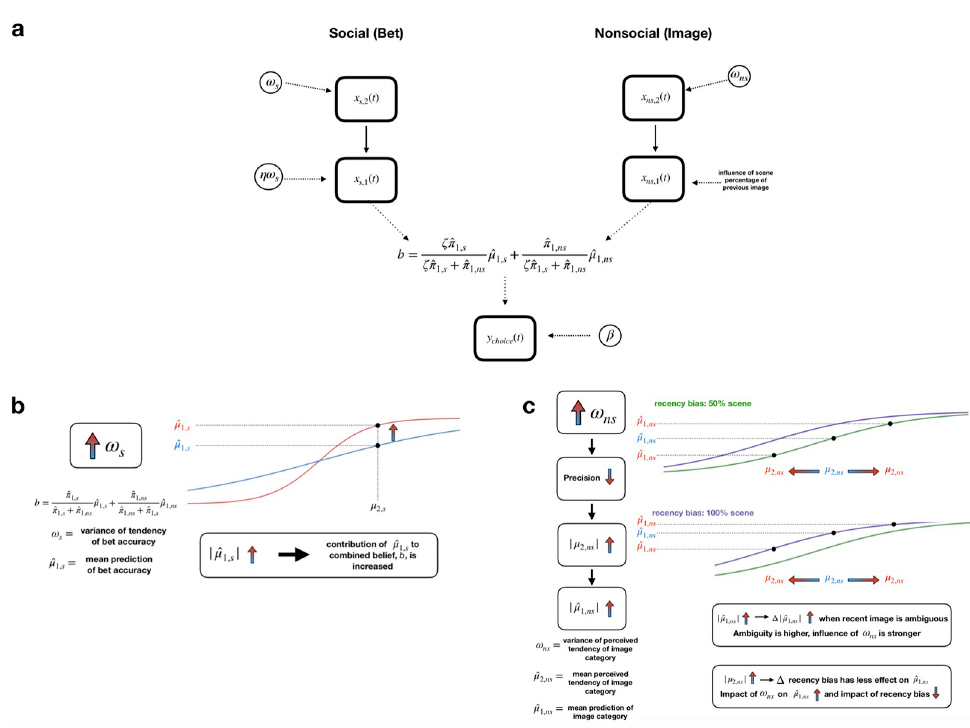
Fig 2. A , the 2-level HGF with parallel processing streams for social and non-social stimuli. The choice data is fed into the model, which is inverted to obtain parameter estimations for an individual. The perceptual model includes the both the social and non-social information, which is then used to compute the combined belief, b . This combined belief is the input to the response model. More details are given in the methods. B , increasing ω s causes the prediction about the accuracy of the bet ( ^ m ) to become closer to an extreme (1 or 0). This tilts the combined belief towards this prediction. C , 1 ; s increasing ω ns causes the recency bias to have less of an effect on the prediction about the image categorization ( ^ m while perceived tendency (second level belief) dominates the prediction. The effect is stronger when the recent image is very